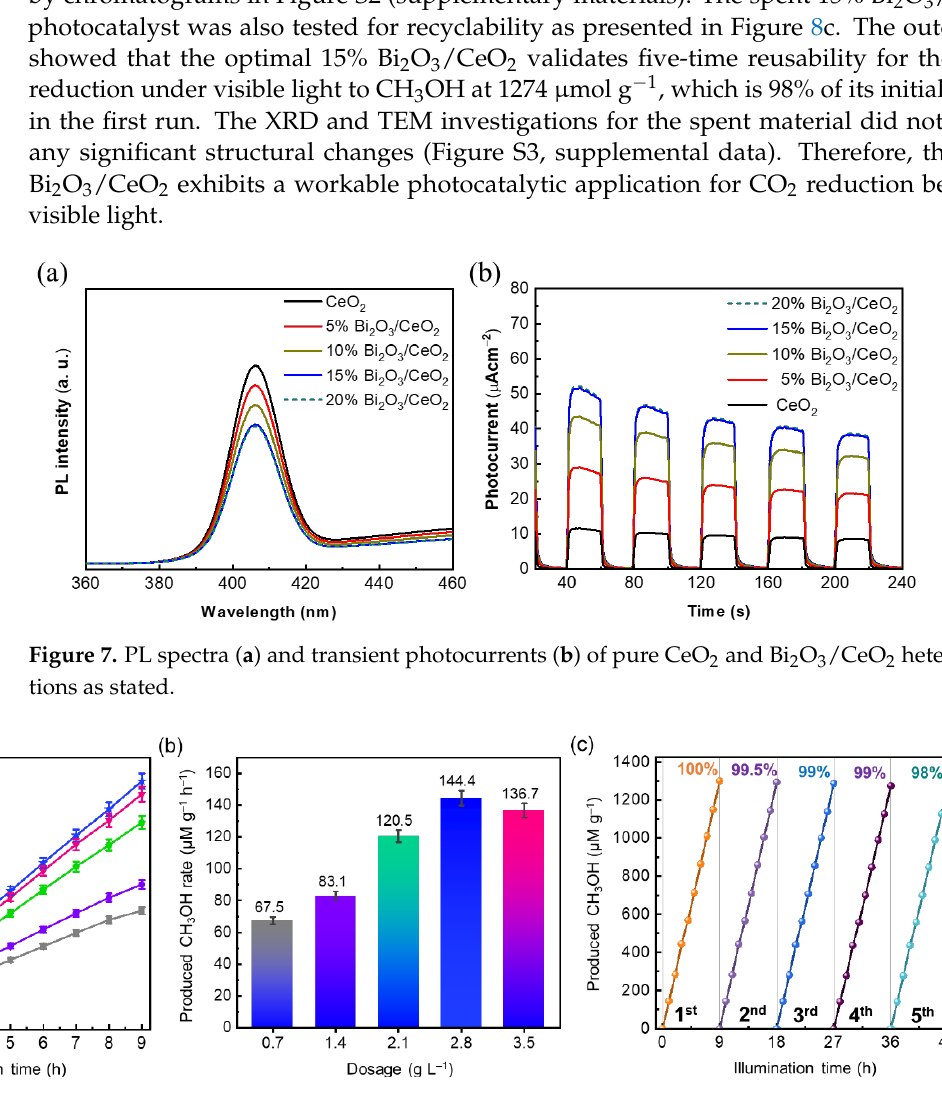
Figure 8. Photocatalytic production of CH 3 OH over different doses (in g L − 1 ) of 15% Bi 2 O 3 /CeO 2 heterojunctions as in ( a ). The influence of dosage on the generation rate of produced CH 3 OH is illustrated in ( b ). The reusability of the best-performing spent photocatalyst dose (2.8 g L − 1 ) is illustrated in ( c ).